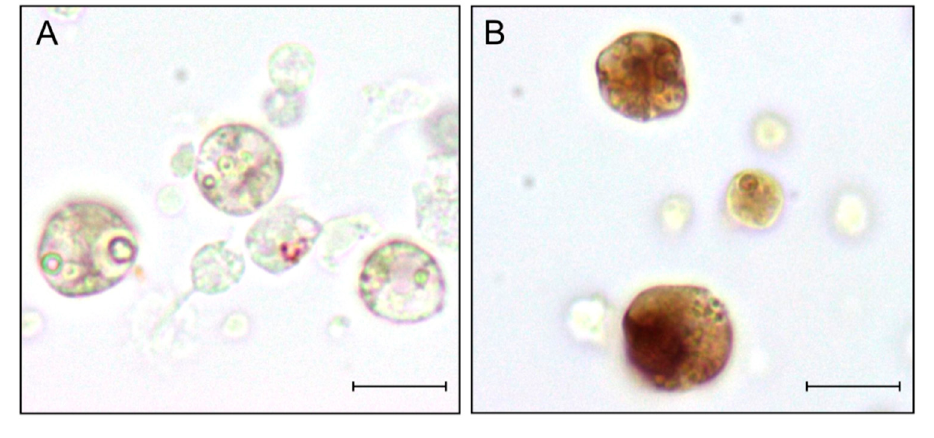
Figure5. ISHwithriboprobesfor bsc3a / c5ar onhemocytemonolayers. ( A ):senseriboprobe; ( B ):antisense Figure 5. ISH with riboprobes for bsc3a/c5ar on hemocyte monolayers. ( A ): sense riboprobe; ( B ): riboprobe. Scale bar: 10 µ m. antisense riboprobe. Scale bar: 10 μ m.